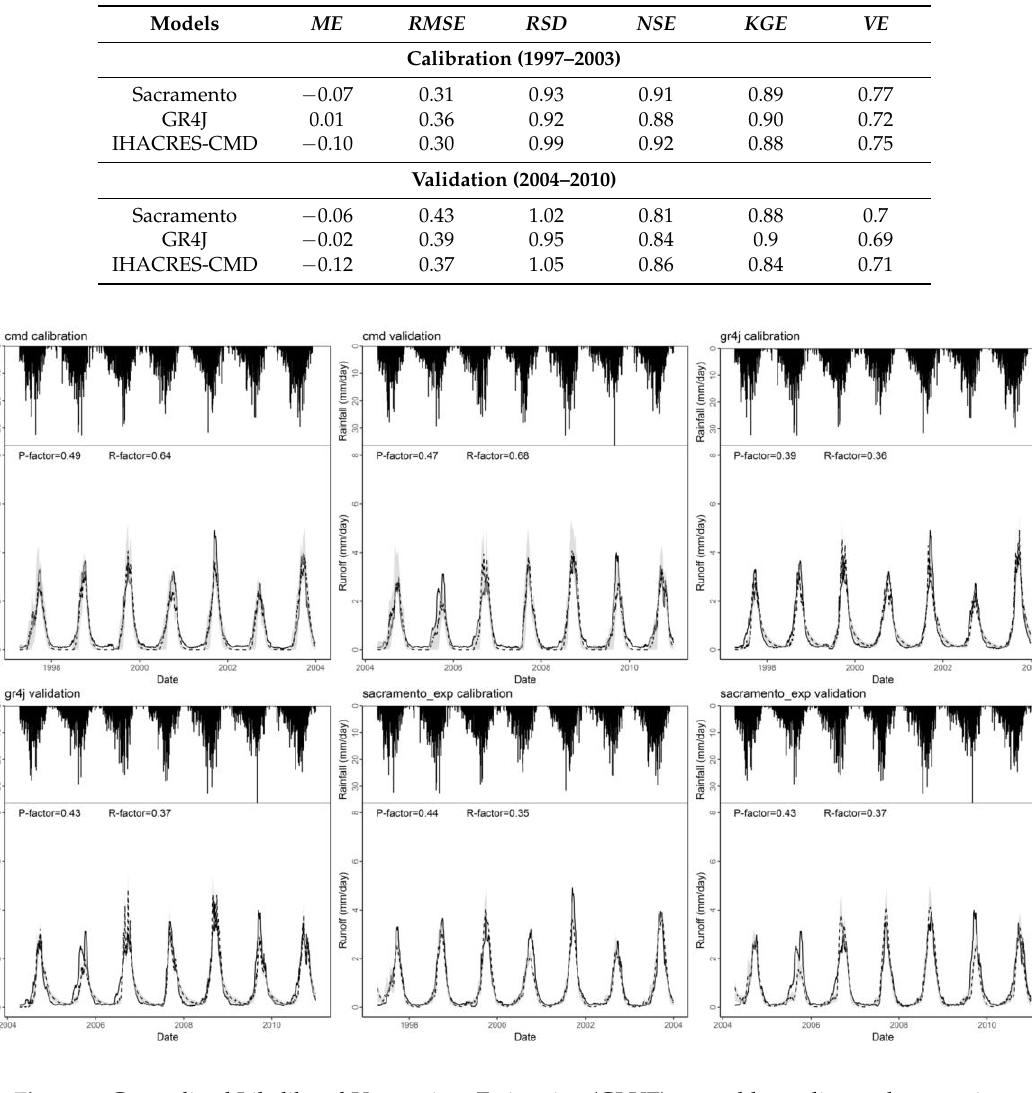
Figure 2. Generalized Likelihood Uncertainty Estimation (GLUE) ensemble median and uncertainty bands from behavioural parameters of 10,000 parameter sets during the calibration (1997–2003) and validation (2004–2010) periods.